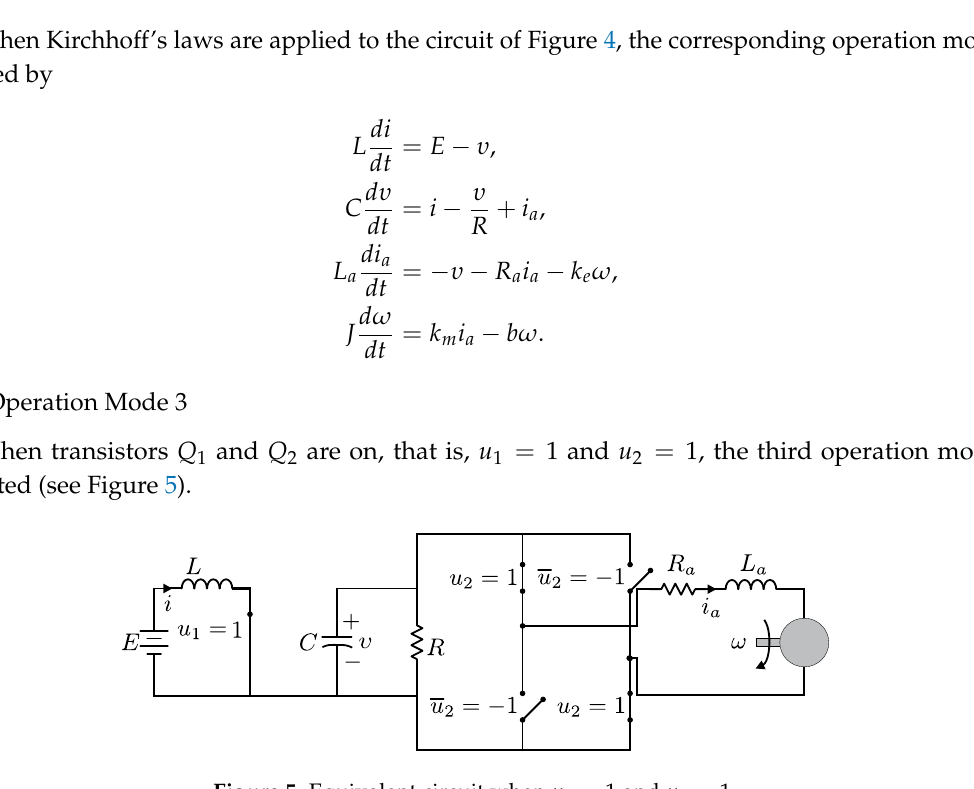
Figure 5. Equivalent circuit when u 1 = 1 and u 2 =